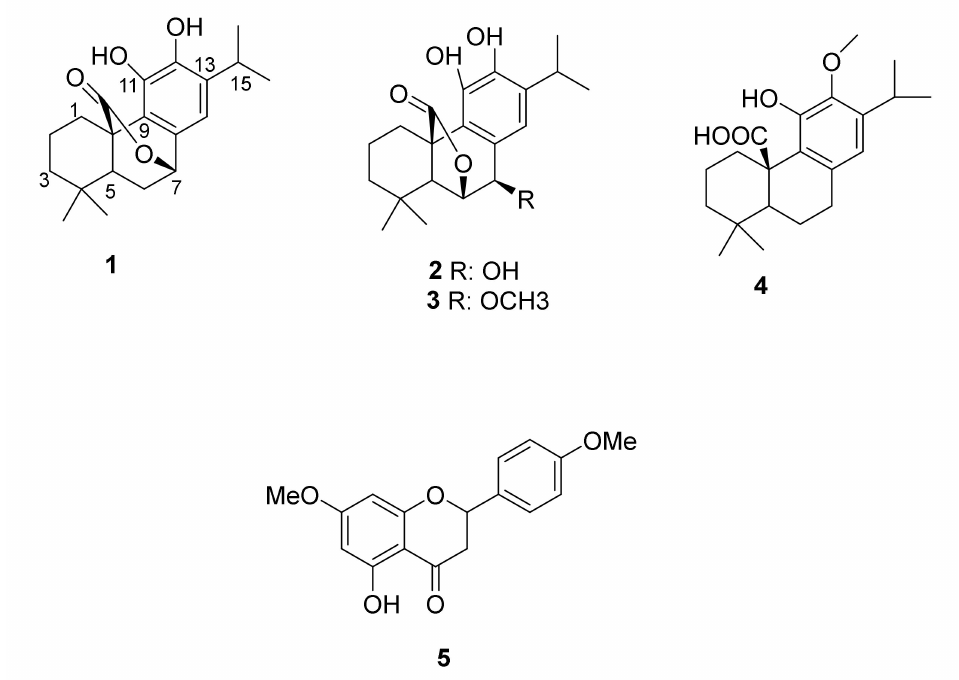
Figure 1. Chemical structures of the isolated compounds ( 1 – 5 ) from Salvia aurita